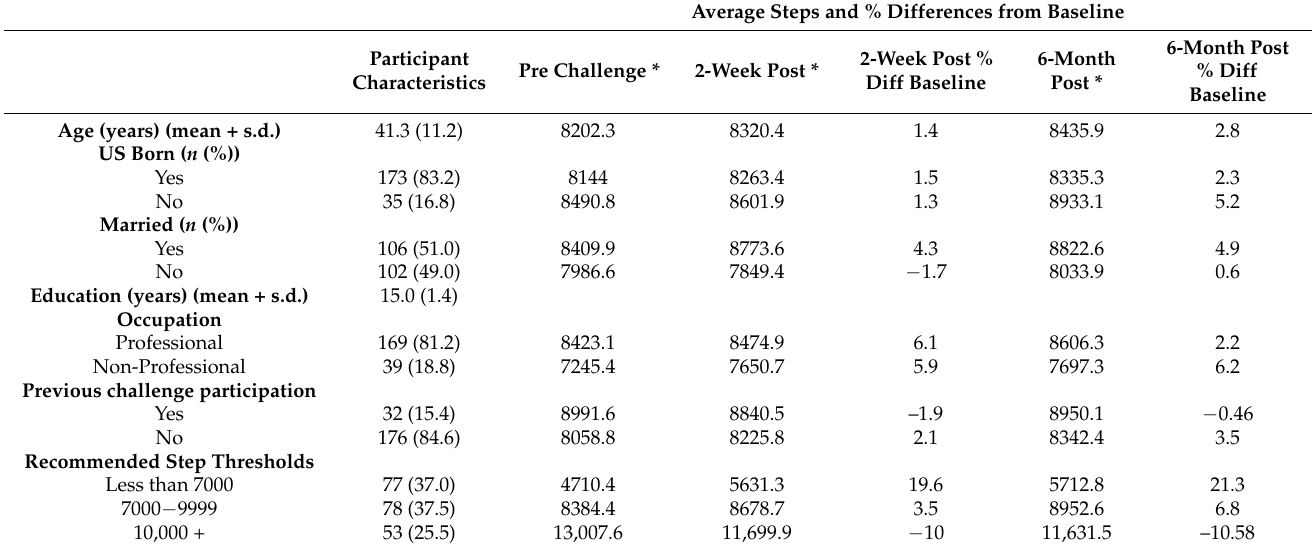
Table 1. Participant demographic characteristics, time point average steps, and percent differences from baseline. Average Steps and % Differences from